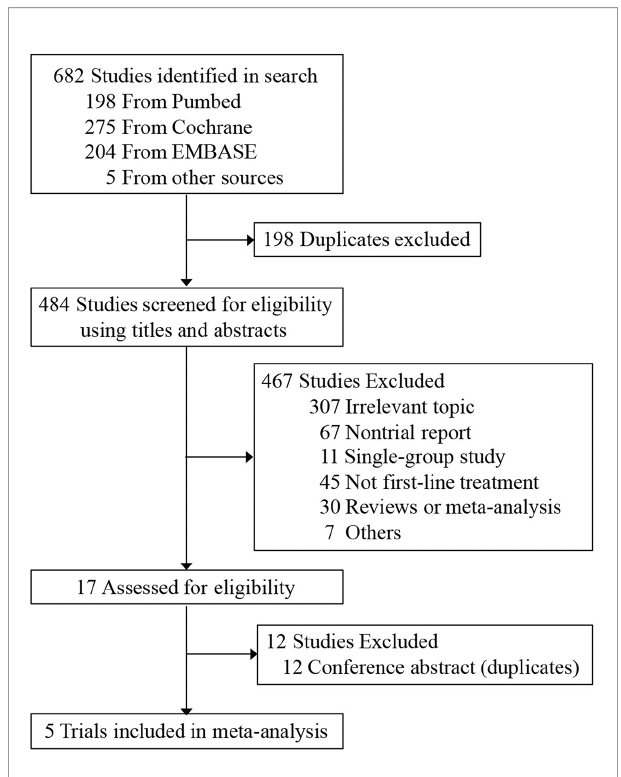
( Figure2A ).ForPFS, atezolizumabpluschemotherapysigni fi